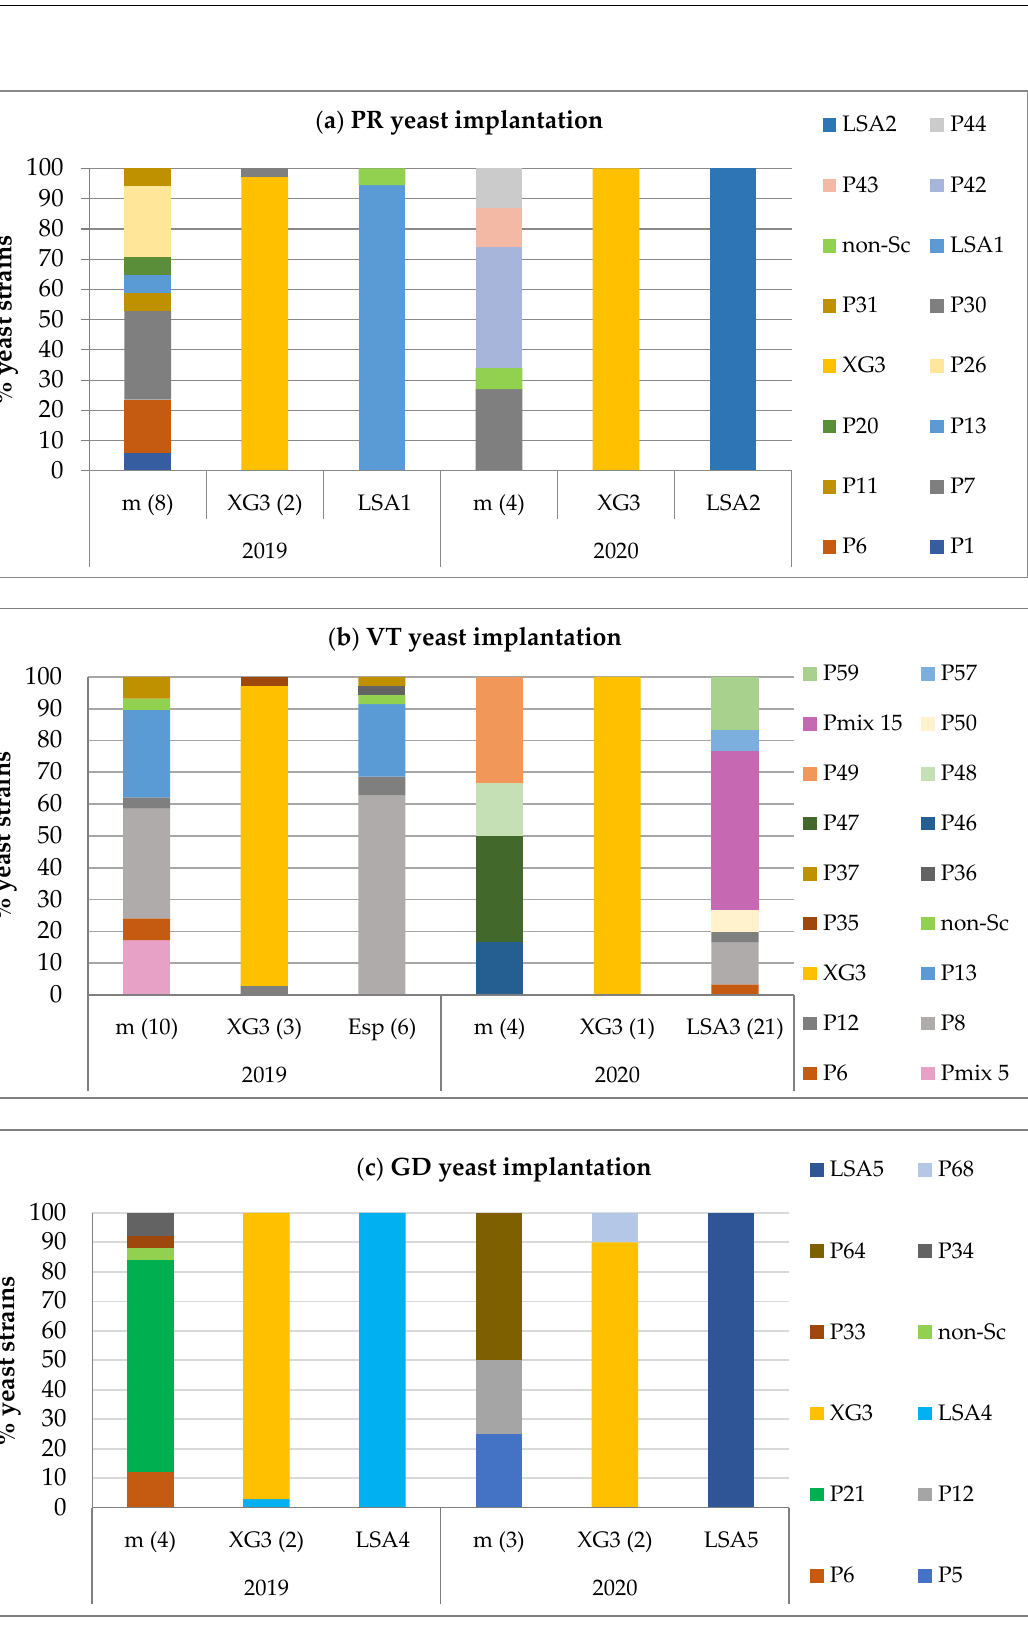
Figure 3. Inoculum implantation: Frequency of yeast strains in must (m) and fermentations with different yeast in 2019 and 2020. ( a ) Priorato de Razamonde (PR), ( b ) O´Ventosela (VT) and ( c ) Gandalera (GD). P1 to P68, XG3 and LSA1 to LSA 5 are different strains of S. cerevisiae . Non-Sc is non- Saccharomyces species. Pmix 5 and Pmix 15—the sum of frequencies of 5 and 15 different strains, respectively.